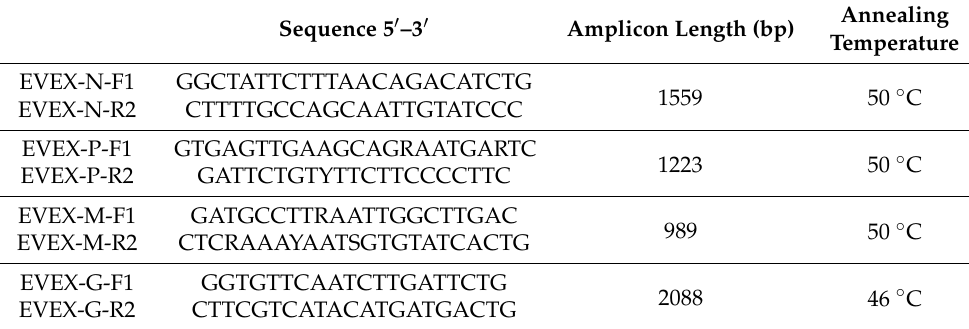
Table 1. Set of primers designed for phylogenetic analysis of isolated